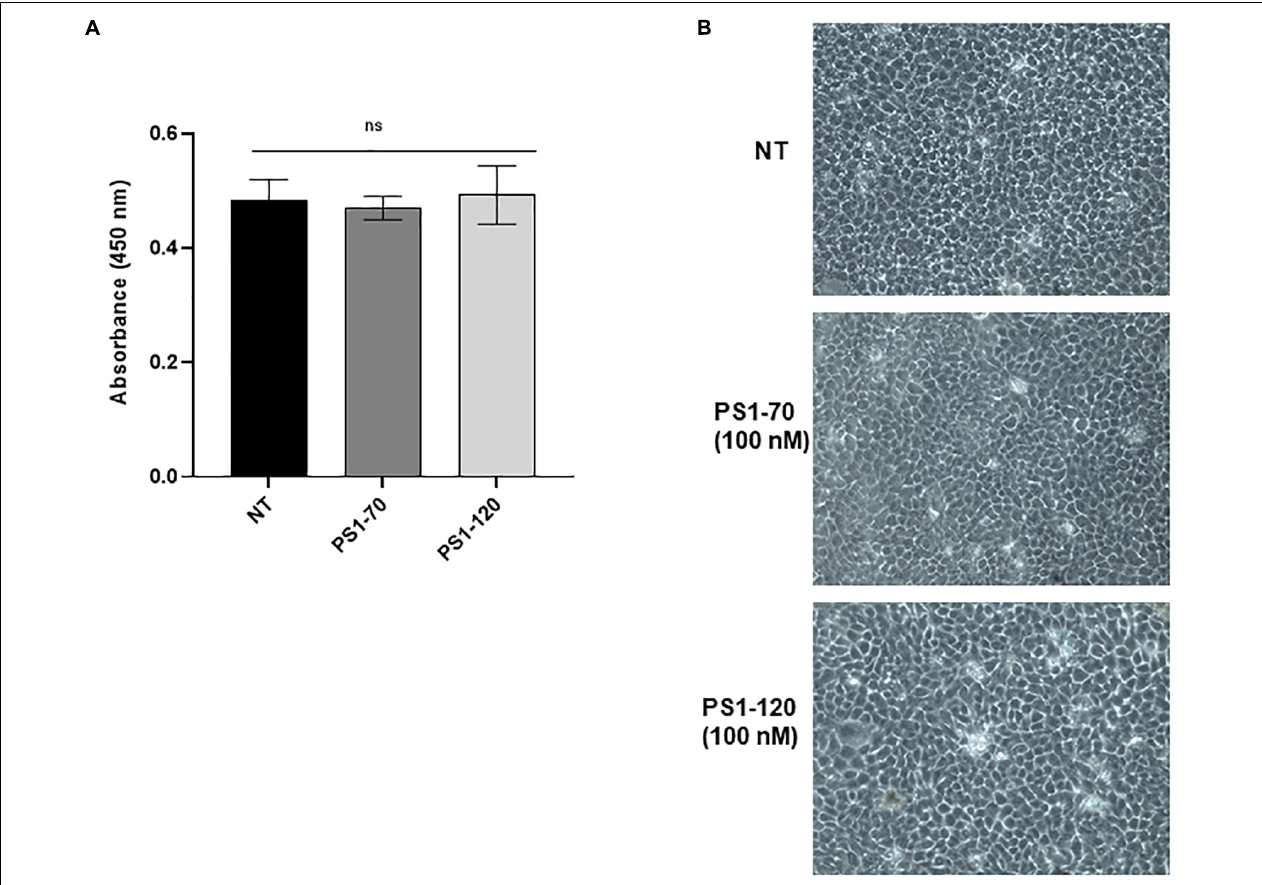
FIGURE 7 | Cell viability and morphology of human keratinocyte cells (HaCaT cells) treated with PS1-70 or PS1-120. (A) Cell viability of HaCaT, incubated at 37 ◦ C for 24 h in the absence (NT) or presence of PS1-70 or PS1-120 at 100 nM, was evaluated by CCK-8 assay. (B) Phase-contrast microscopy images of HaCaT cells not treated (NT) or treated with 100 nM of PS1-70 or PS1-120 at 37 ◦ C for 24 h. The microscope images were representative of three independent experiments performed in triplicate. Bars are presented as mean (Student’s t -test, P < 0.05). Error bars indicate standard